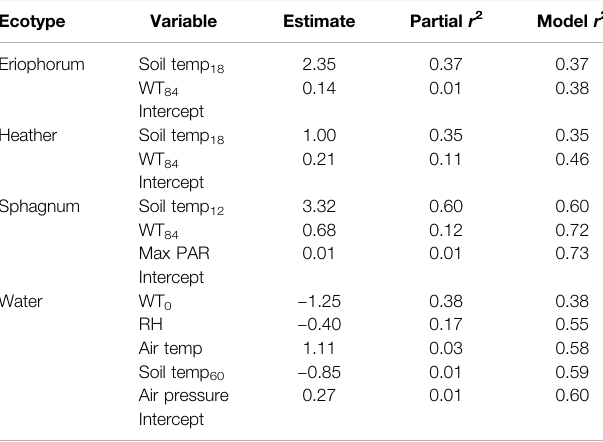
TABLE 2 | Multiple regression models of signi fi cant ( p < 0.05) environmental variables